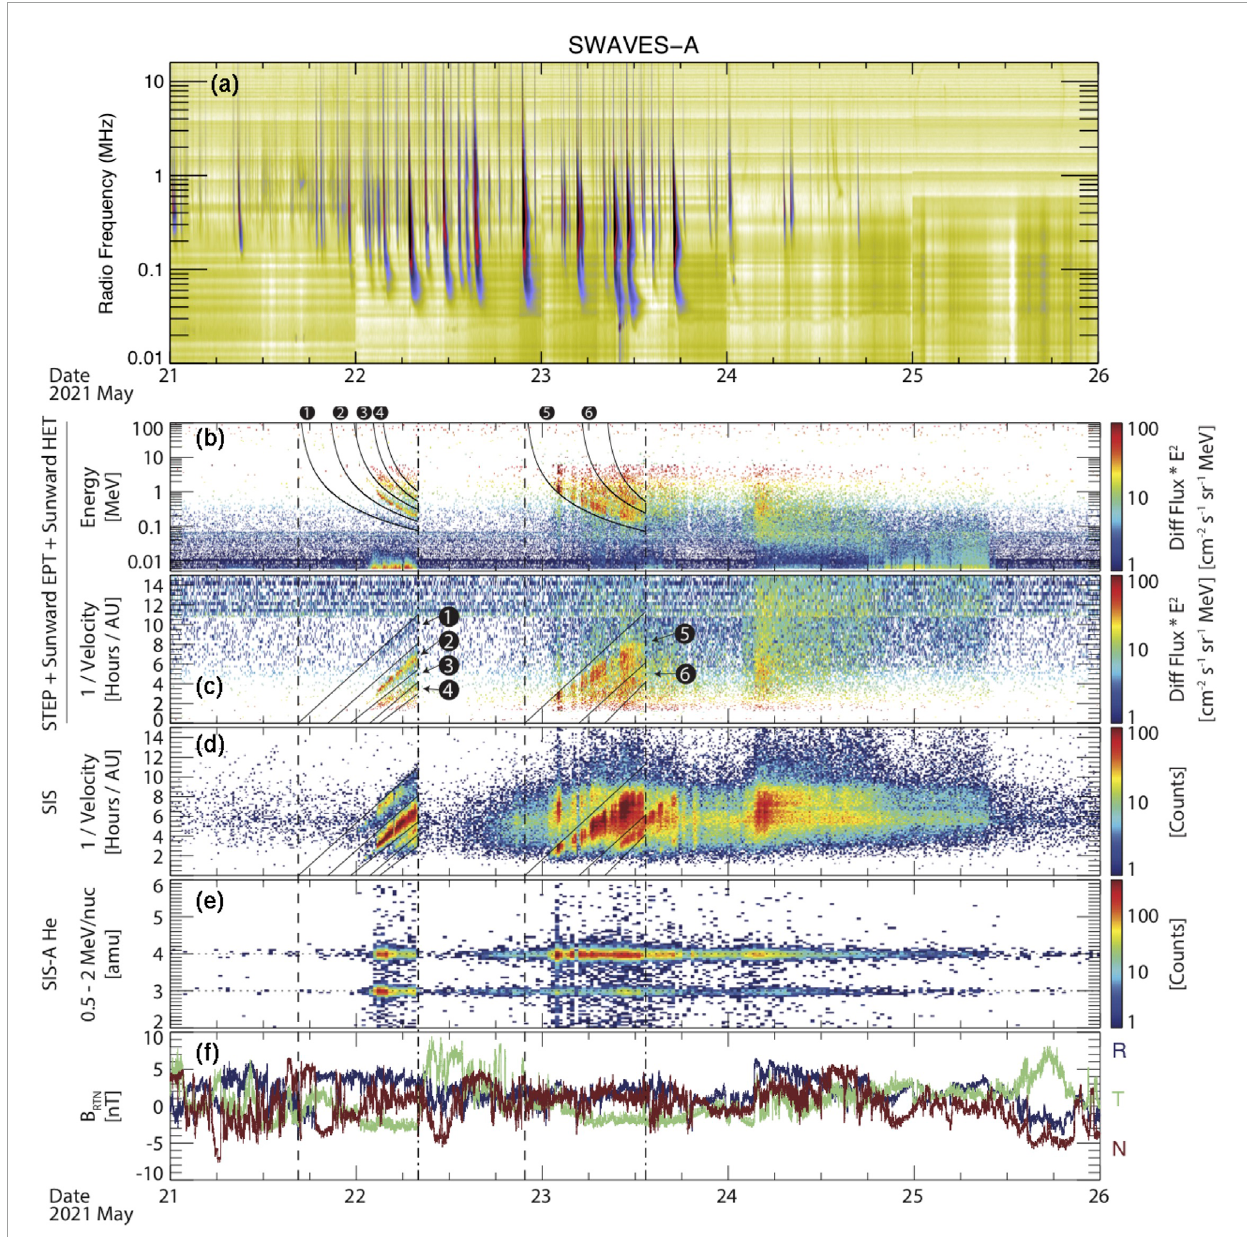
FIGURE 1 Radio, energetic particle and interplanetary magnetic field for the 5-day period starting 21 May 2021. (A) Radio dynamic spectra from SWAVES-A. (B, C) The total ion energy and the total ion inverse velocity from STEP, EPT and HET. (D) The inverse velocity of heavy ions as measured by SIS. (E) The mass spectrogram for helium isotopes from SIS. (F) The interplanetary magnetic field (IMF) in RTN coordinates from MAG. Of the four vertical lines in panels (B – F) , which are reproduced from Ho et al. (2022), the first and third (dashed) mark the estimated times of injections 1 and 5, and the second and fourth (dashed-dot) the dropouts that ended the first and second sets of 3 He-rich SEP